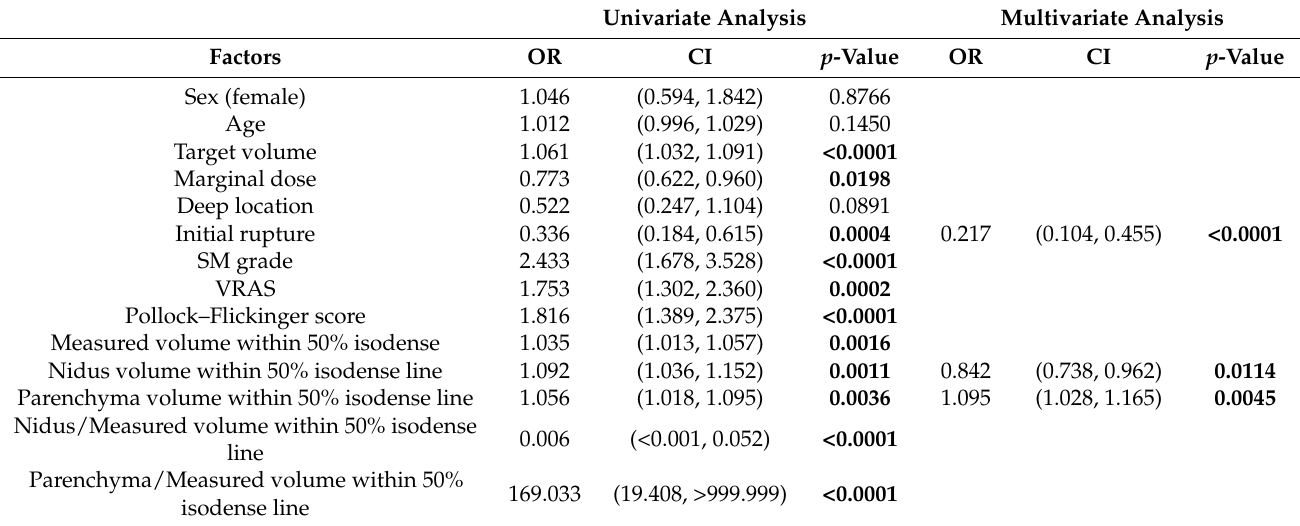
Table 4. Univariate and multivariate ordinal logistic regression analyses for predictors of radiation-induced change (RIC) grade after